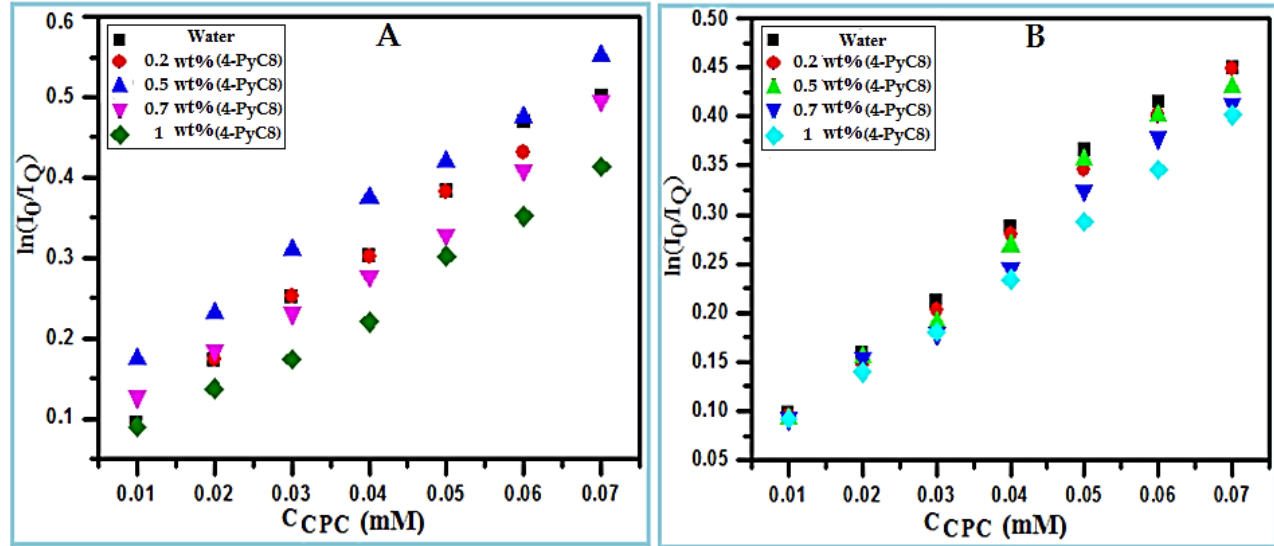
Figure 4. Plots of ln(I 0 /I Q ) vs. concentration of CPC (0.12 mM) in different mass fractions of the IL 4-PyC8 at 300 K: ( A ) 16-10-16 and ( B ) 16-12-16. [16- s -16] = 1